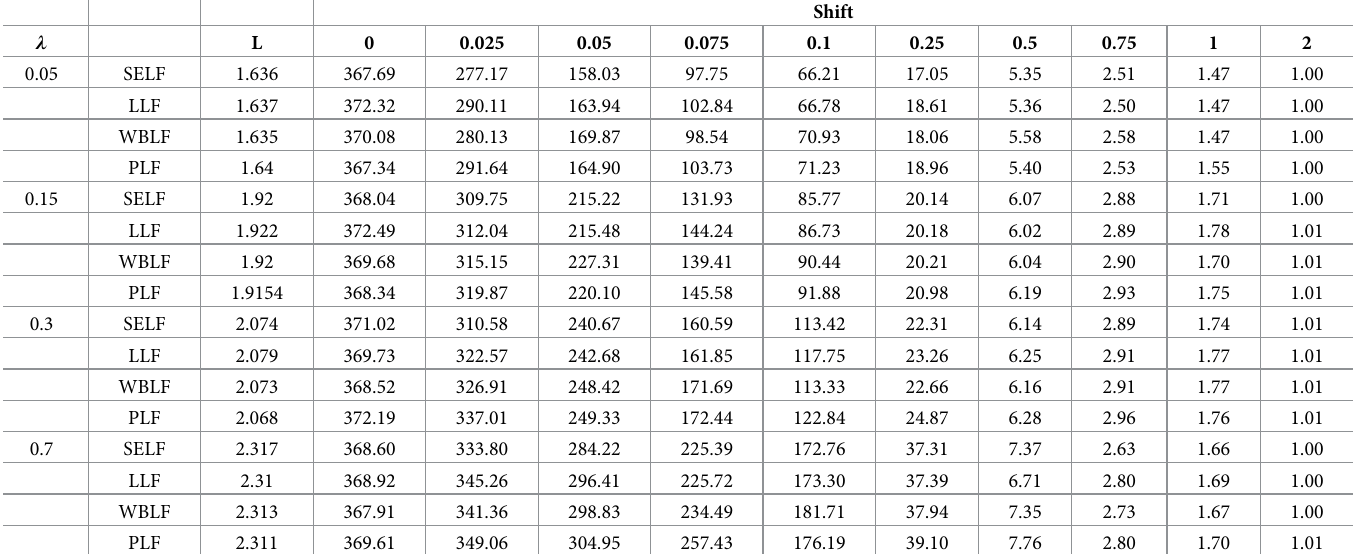
Table 1. ARL comparison for n = 5 under various loss function for ARL 0 = 370.